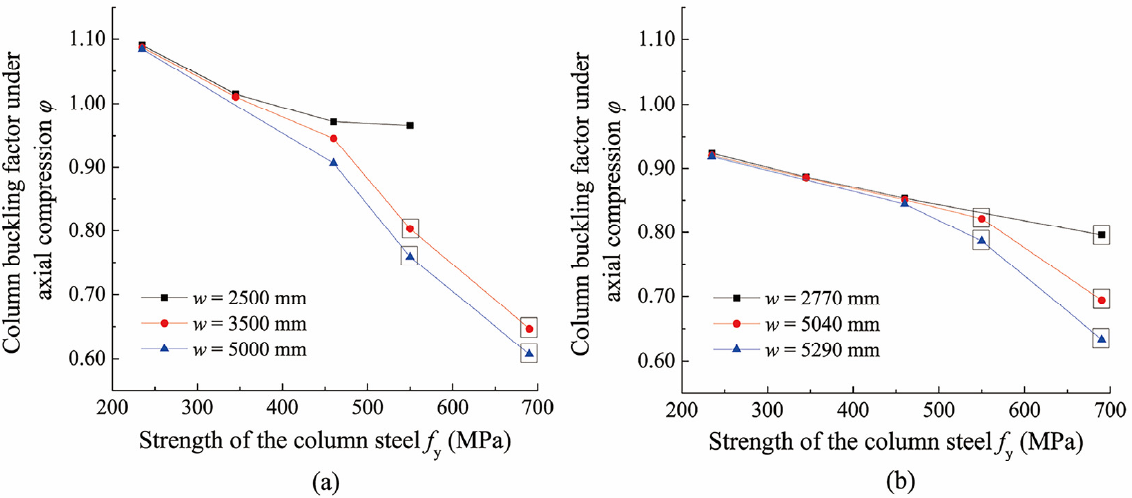
Figure 14. Relationship between column buckling factor and yield strength of the column steel for varying wallboard widths: ( a ) Model M2- w , ( b ) Model M4- w .